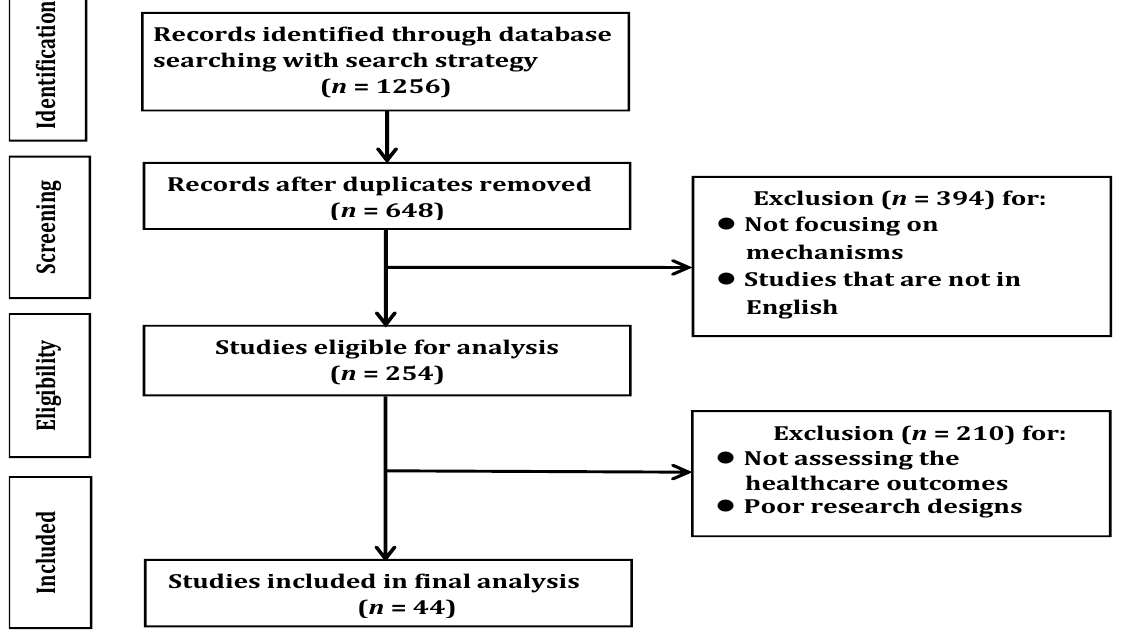
Figure 1. Preferred Reporting Items for Systematic Review and Meta-Analysis Protocols (PRISMA-P).